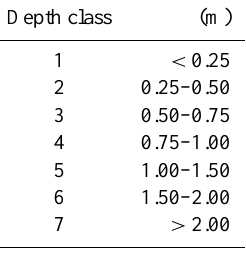
Table 3. Debris factor (DF) for different pattern of water depth and velocity in urban areas (DEFRA, 2006).